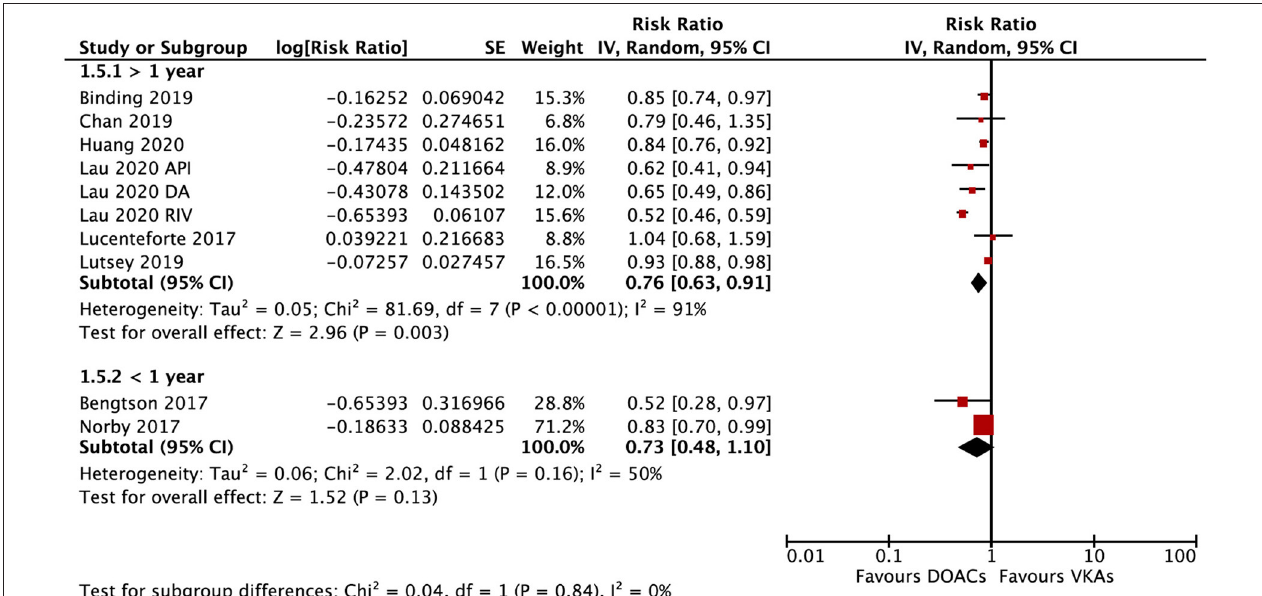
FIGURE 5 | Subgroup analysis based on the follow-up time regarding the risk of fractures of DOACs vs. VKAs in AF patients. AF, atrial fibrillation; DOACs, direct oral anticoagulants; DA, dabigatran; RIV, rivaroxaban; API, apixaban; CI, confidence interval; SE, standard error; IV, inverse of the